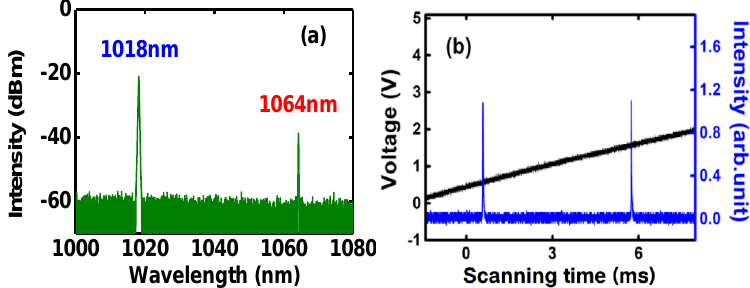
Figure 2. Measured ( a ) output dual-wavelength spectrum and ( b ) interference result of the SF pump source using the Fabry–Perot interferometer.